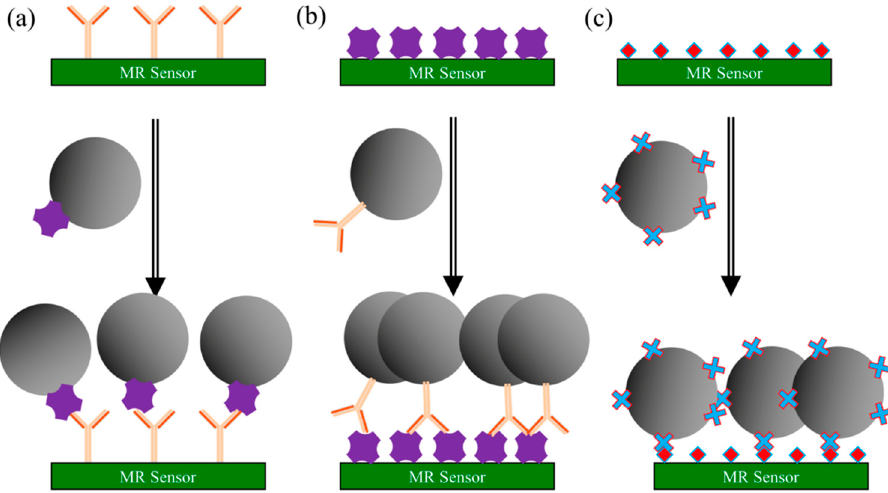
Figure 7. Schematic view of direct assays. ( a ) MR sensor surface pre ‐ coated with target antibodies from testing sample followed by adding MNP ‐ linked antigens for specific binding. The number of captured MNPs through antigen ‐ antibody conjugations is proportional to the electrical/magnetic signals from MR sensors; ( b ) MR sensor surface pre ‐ coated with target antigens from testing sample followed by adding MNP ‐ linked antibodies; ( c ) MR sensor surface pre ‐ coated with biotin followed by adding streptavidin ‐ coated MNPs. This structure is mostly used as a positive control.